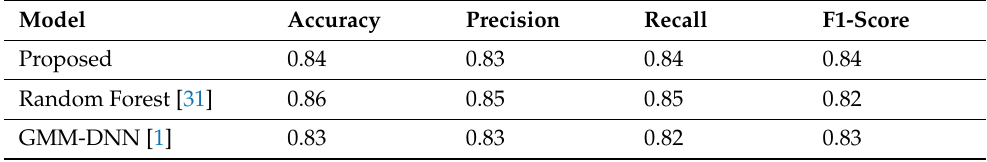
Table 6. Analysis in terms of performance evaluation matrices using the RAVDESS dataset.